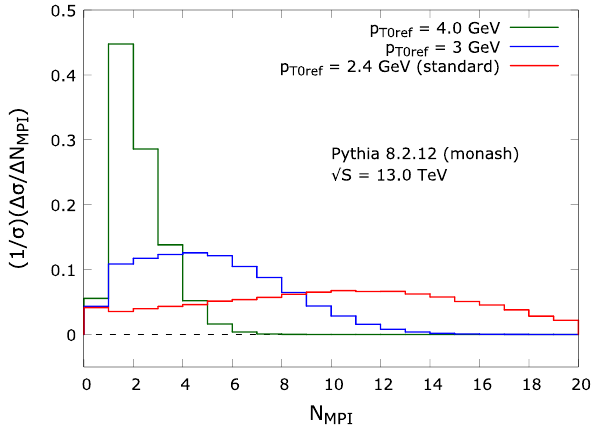
Fig. 12 The distribution of number of parton interactions N MPI for differentsettingsof p T 0 cutoff.Theeventswith N MPI = 0arediffractive events